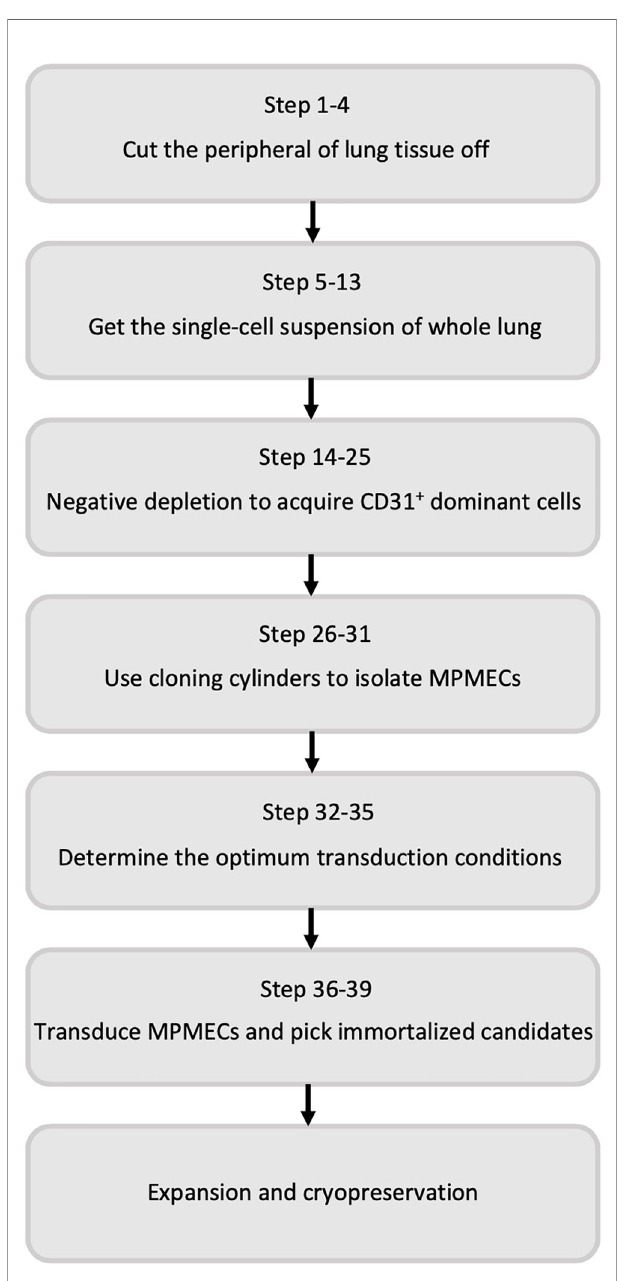
FIGURE 1 | Flow diagram of the steps involved in primary mouse pulmonary microvascular endothelial cell isolation and immortalized mouse pulmonary microvascular endothelial cell